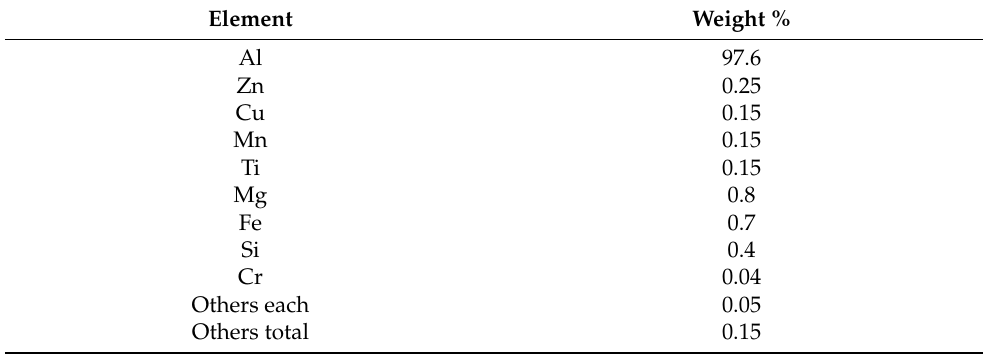
Table 1. Chemical composition of AA6061 [33].